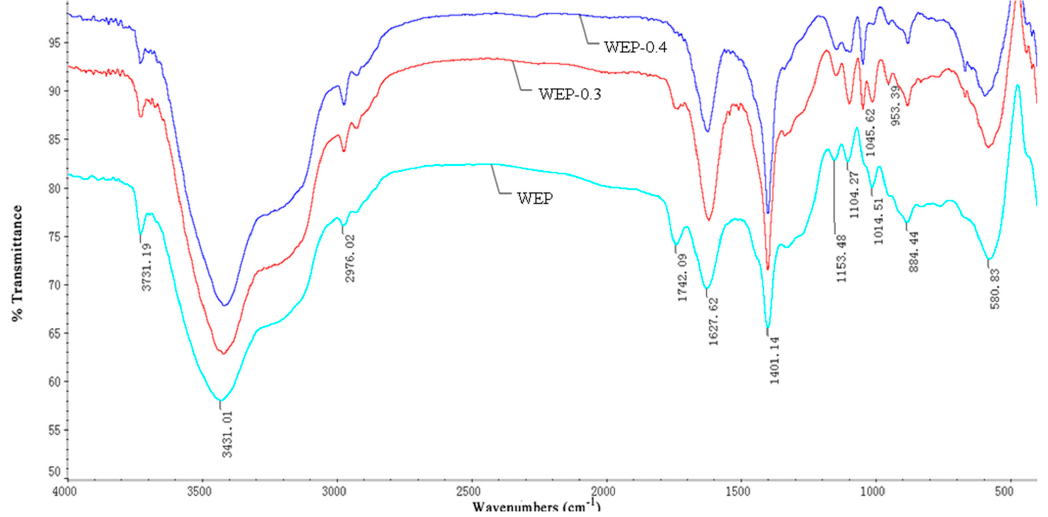
Figure 5. Fourier transform-infrared spectra of WEP and its fractions.